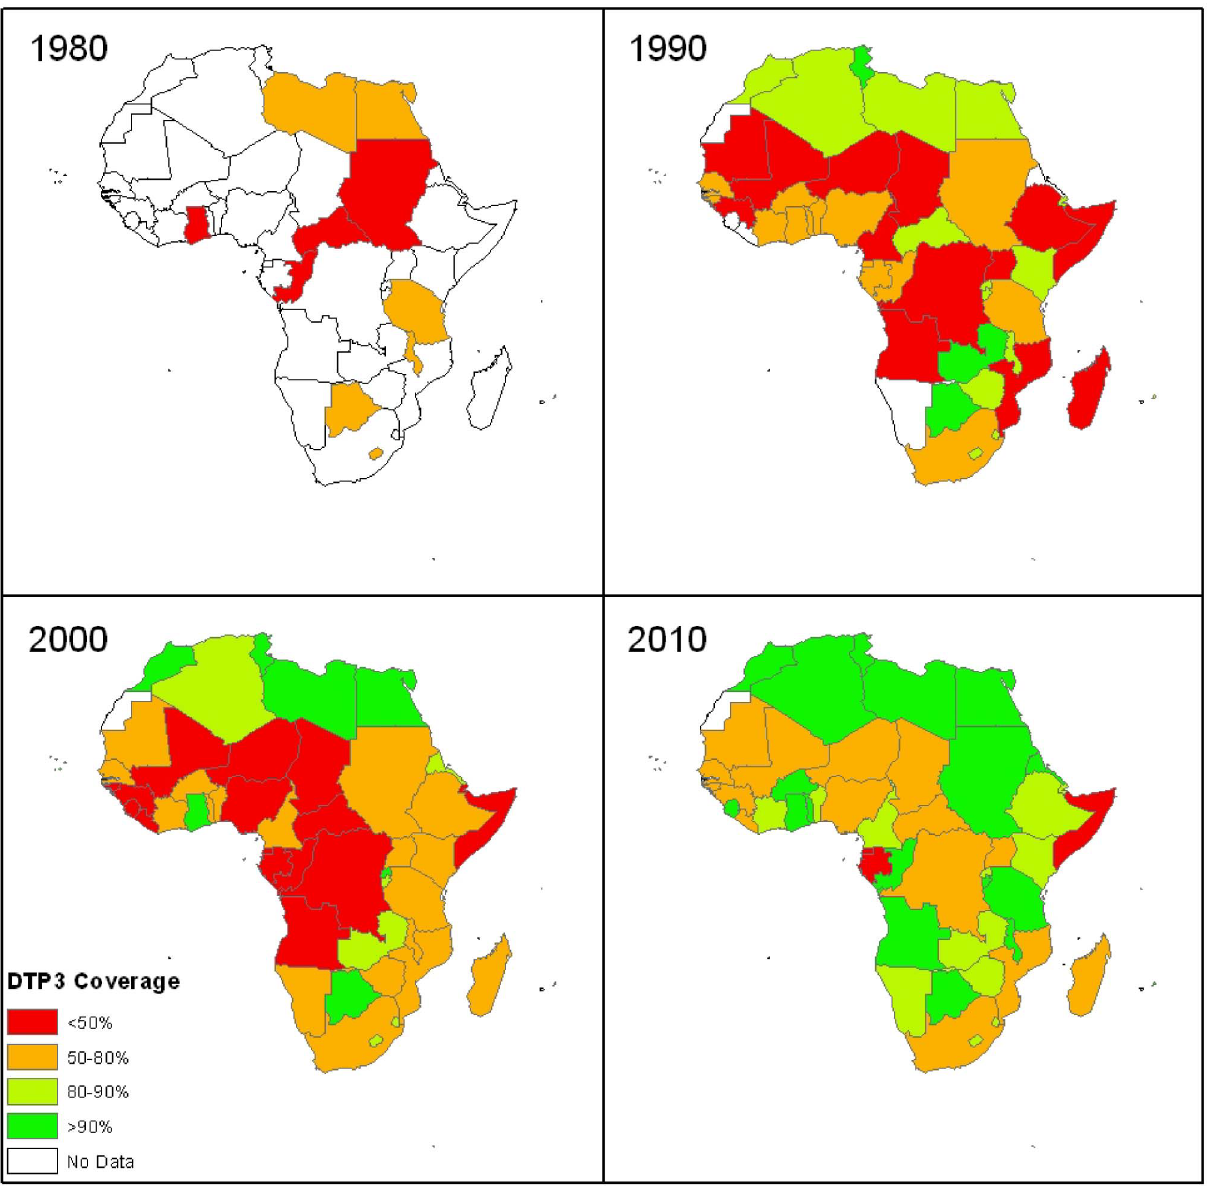
Figure 1. Colour-coded maps of Africa showing national coverage with the third dose of the diphtheria-tetanus-pertussis vaccine (DTP3) at the end of each decade since 1974. (Source of data: World Health Organization